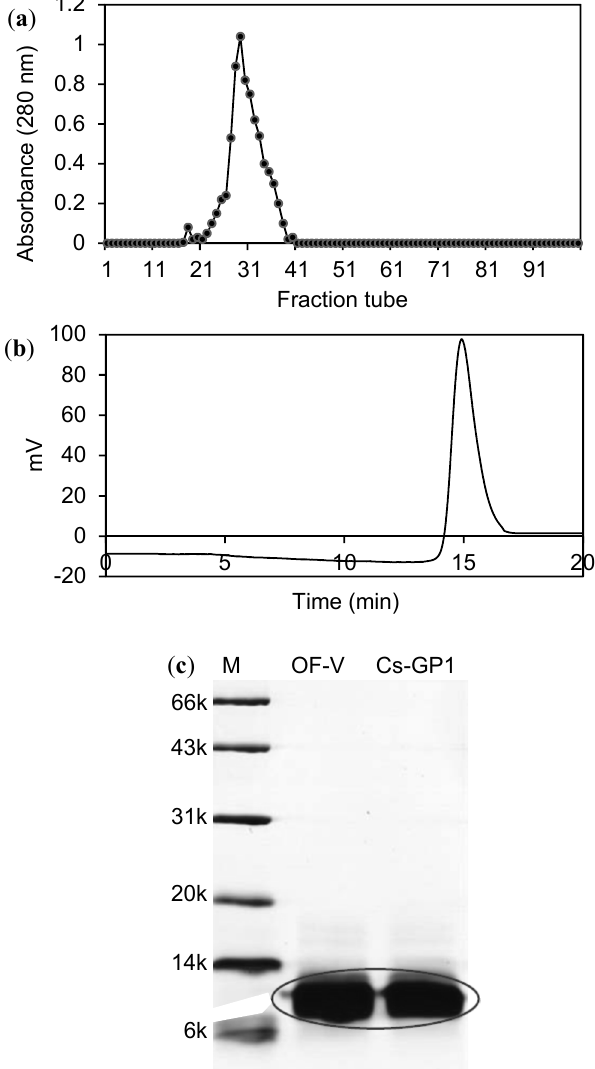
Figure 1. Fractionation and detection of glycopeptide Cs-GP1: ( a ) Ion exchange chromatograph purification of Cs-GP1 fraction on a DEAE 52 column (UV detection); ( b ) HPGPC profile of Cs-GP1 detected by on an Ultrahydrogel 250 column; ( c ) SDS-PAGE.